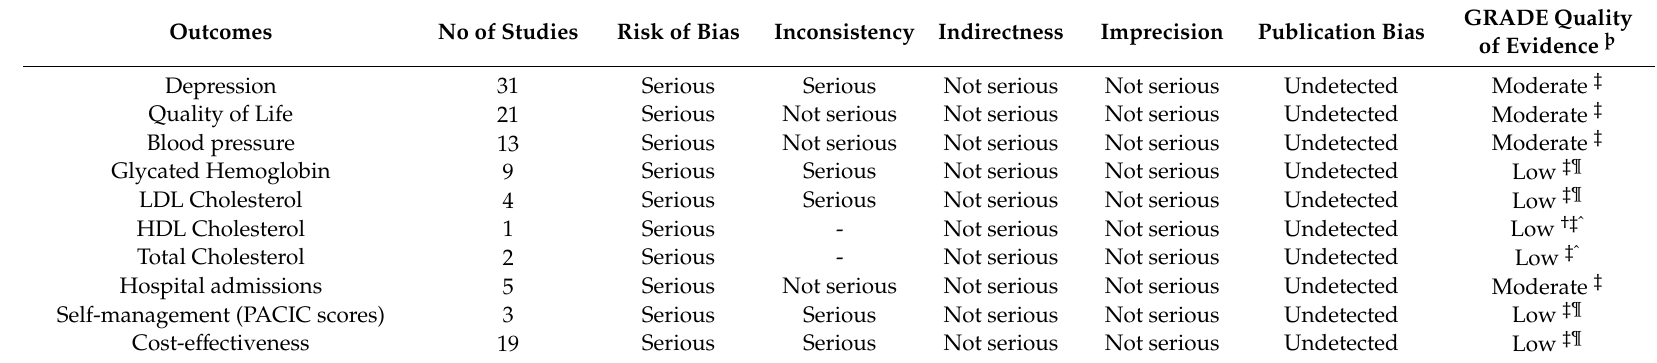
Table 1. Grading of Recommendations, Assessment, Development, and Evaluation (GRADE) assessment of randomised controlled trials reporting e ff ectiveness of patient-centred medical home (PCMH) vs. standard general practitioner (GP) care on outcomes of